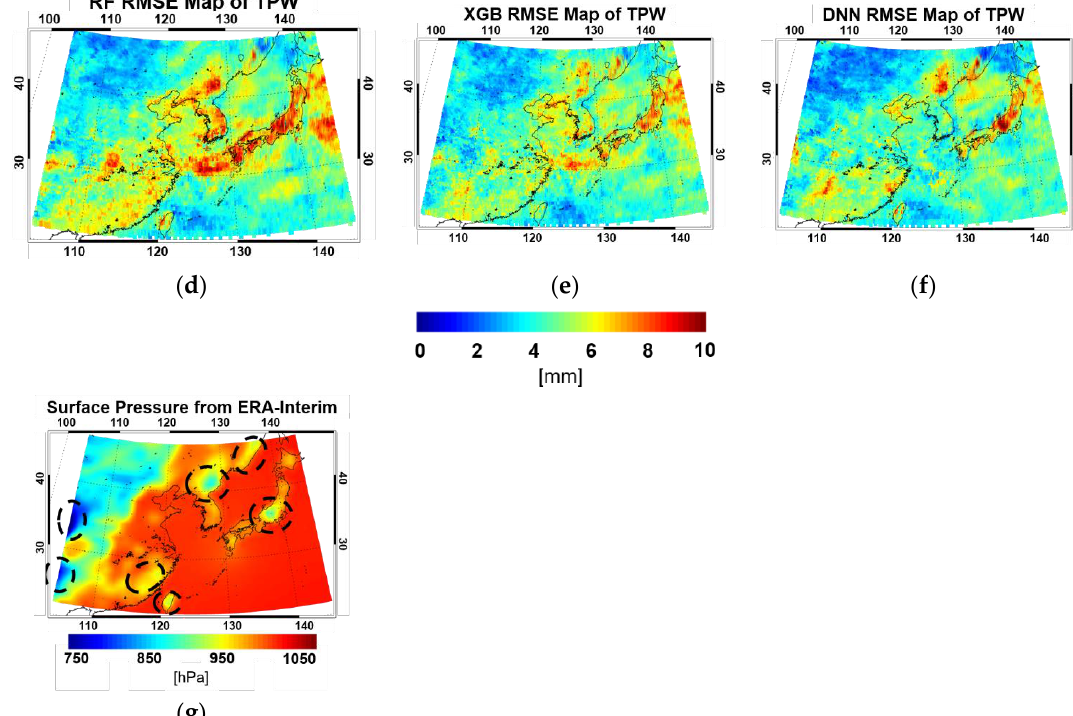
Figure 7. Mean error maps of TPW in Northeast Asia for two years (September 2016 to August 2018). The upper figures represent mean bias (ERA-Interim TPW – retrieved TPW) maps ( a – c ) and the lower figures represent mean RMSE maps ( d – f ). The left, middle, and right figures are the retrieved results from the RF, XGB, and DNN, respectively. ( g ) is the averaged surface pressures using ERA-Interim data from October 2016 to August 2018 in the study region. The black dotted circles indicate relatively lower surface pressures when compared to the surrounding areas.